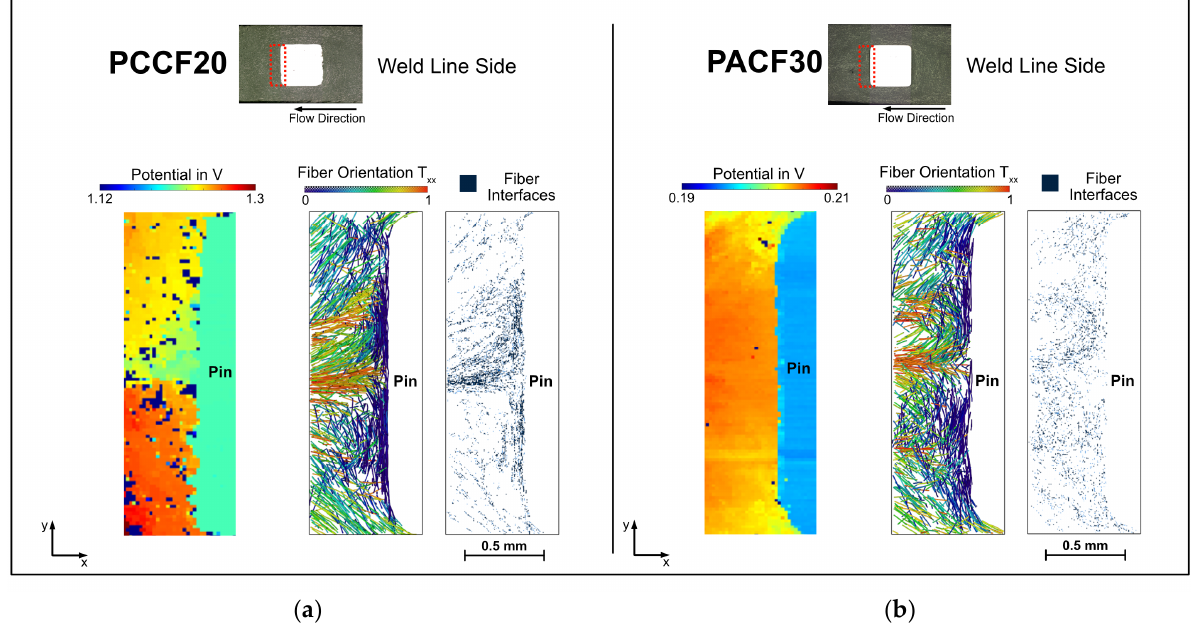
Figure 20. Comparison of the measured potential fields and the fiber orientation at the weld line sides of the specimen PC CF20_4 mm ( a ) and PA CF30_5 mm ( b ).